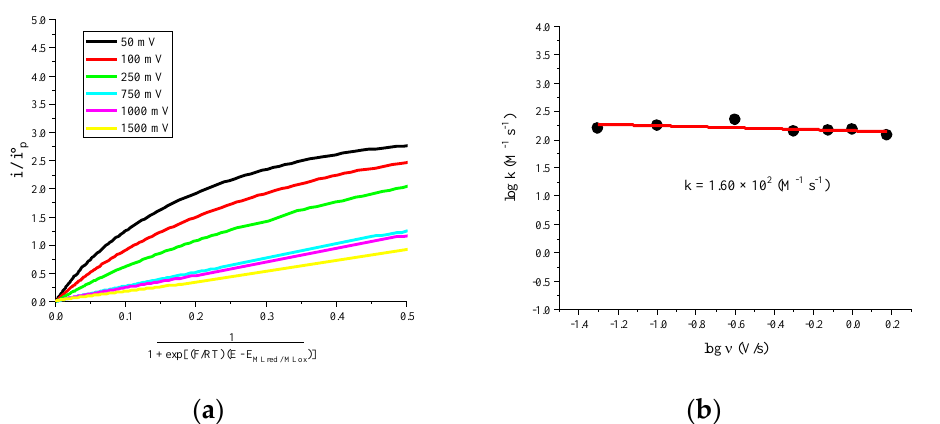
Figure 6. ( a ) FOWA of a 1 mM [Co II (phen) 3 ](BF 4 ) 2 complex in MeCN with 0.1 M of TBAPF 6 as supporting electrolyte. ( b ) Logarithmic rate constant obtained from FOWA.